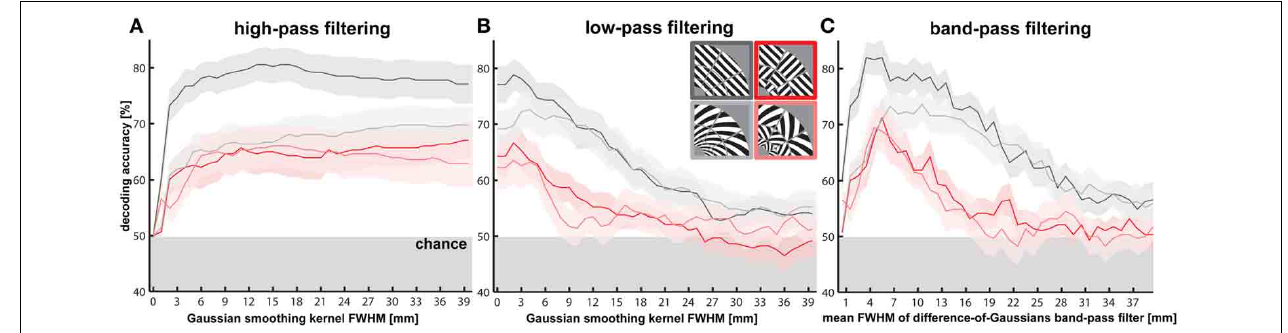
FIGURE 3 | Effects of spatial high-, low- and band-pass filteringof V1 activity patternsonorientationdecodability. Orientation decodability and SEM (shaded area) is plotted for different levels of spatial (A) high- and (B) low-pass filtering of V1 activity patterns using a three dimensional Gaussian kernel with a full width at half maximum (FWHM) ranging from 1 to 40mm in